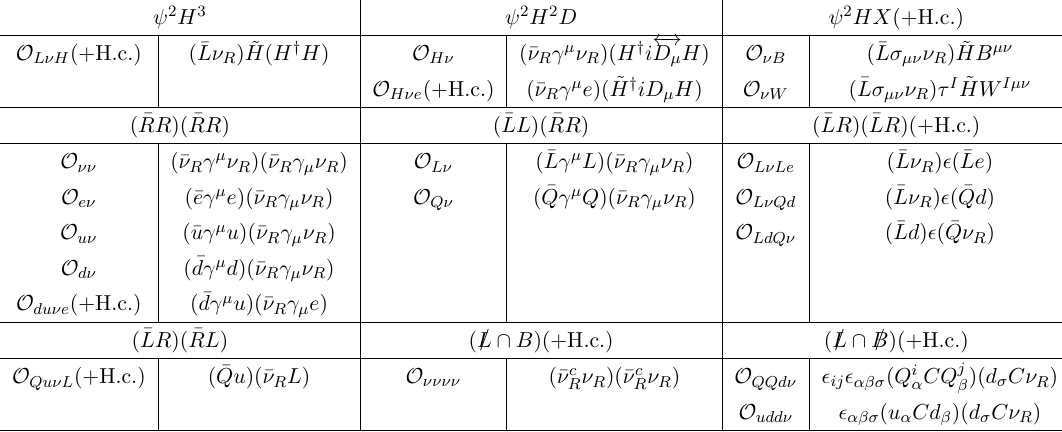
Table 1 . The complete basis of dimension-six operators involving ν R , taken from ref. [47]. Opera- tors are expressed in terms of a column vector of n gauge singlet fields, ν R , and SM fields, i.e., the lepton and Higgs doublets, L and H , left-handed quark doublet Q = ( u L , d L ) T , and right-handed fields e , u , and d